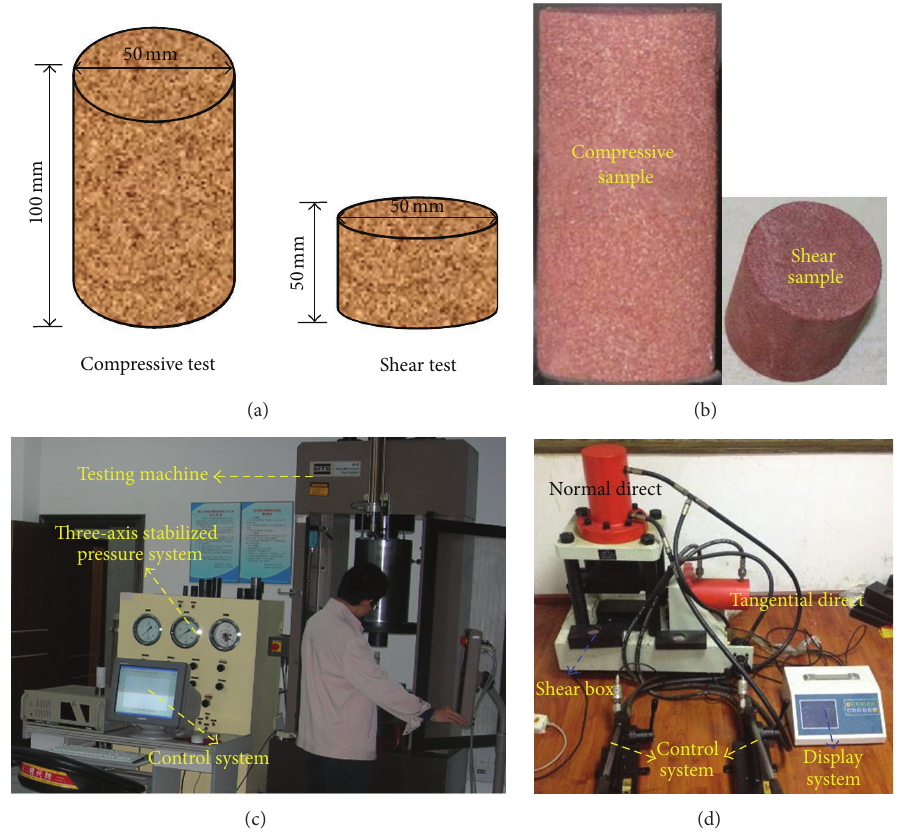
Figure 5: Laboratory test sample size and apparatus: (a) sample size used for the laboratory tests; (b) two natural rock samples for different test; (c) compressive test device (MTS 815 rock mechanics test systems); and (d) direct shear strength test